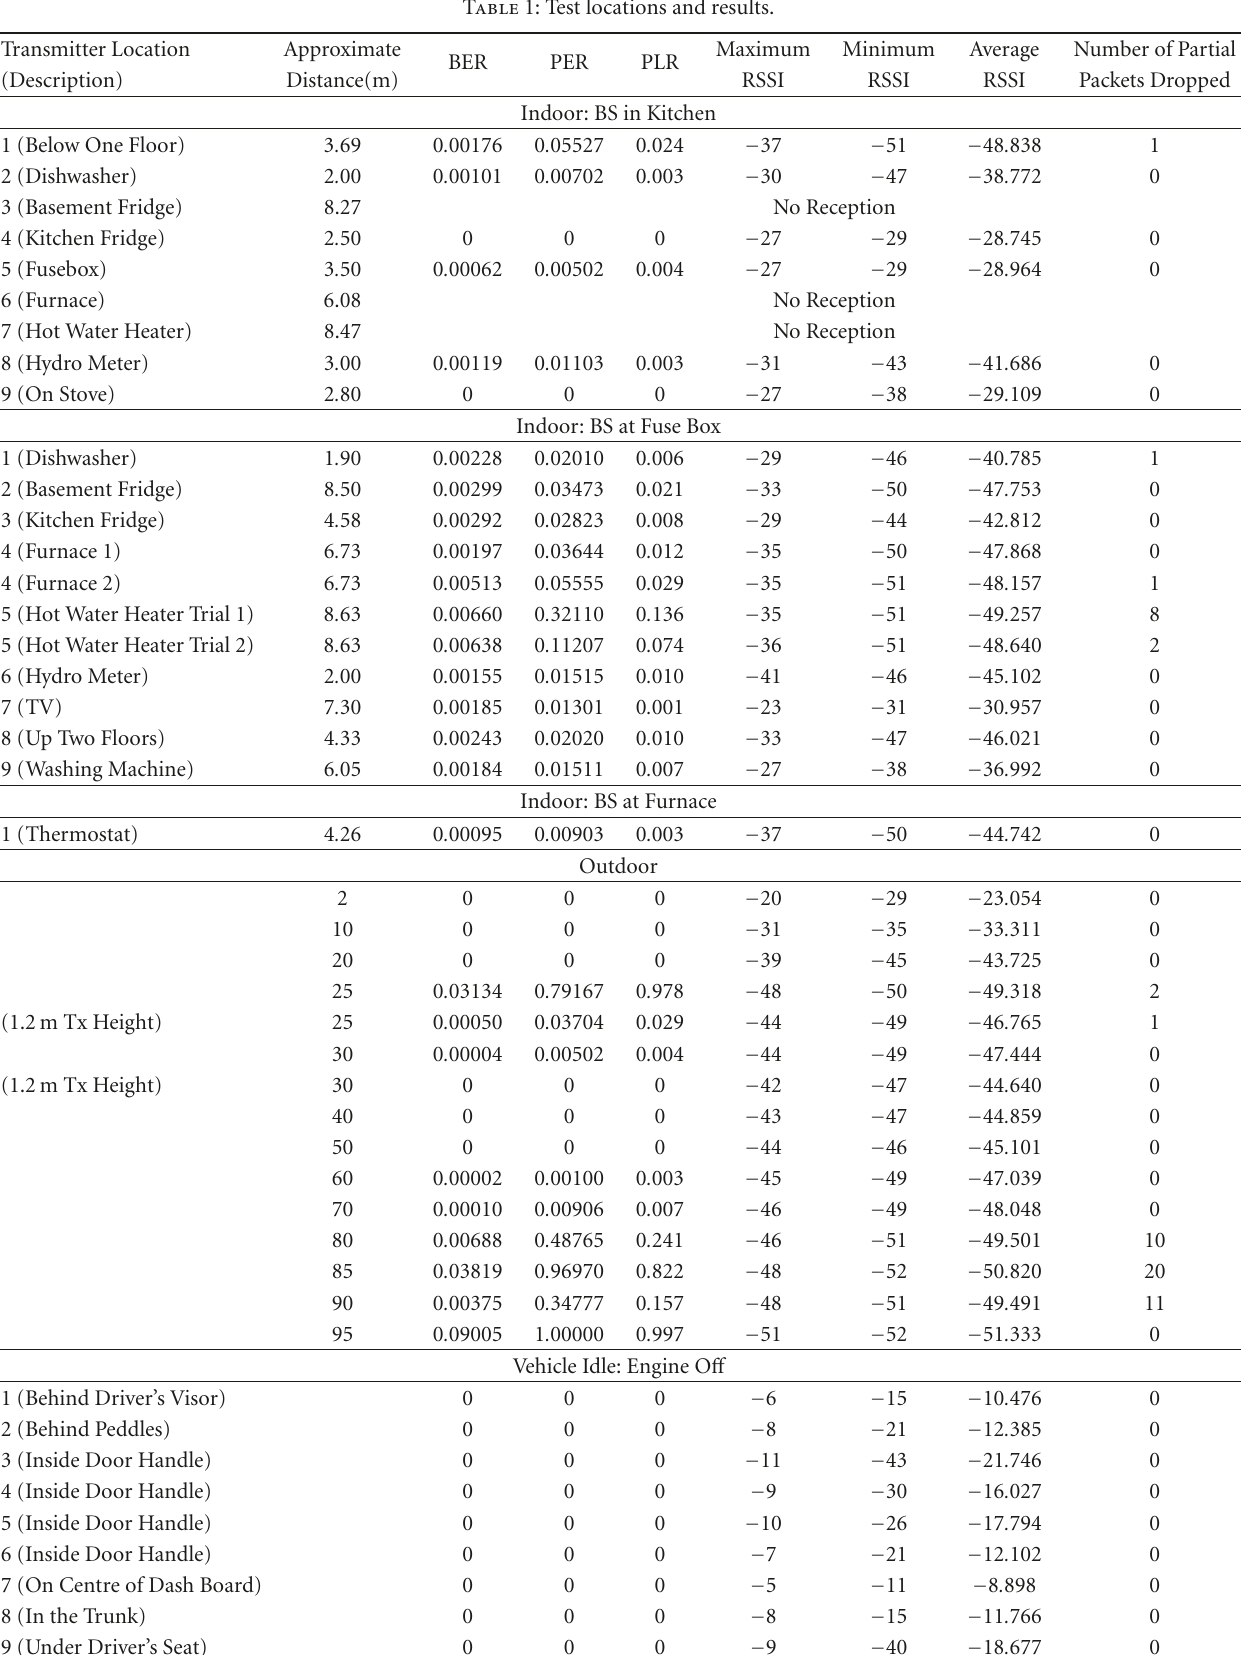
Table 1: Test locations and